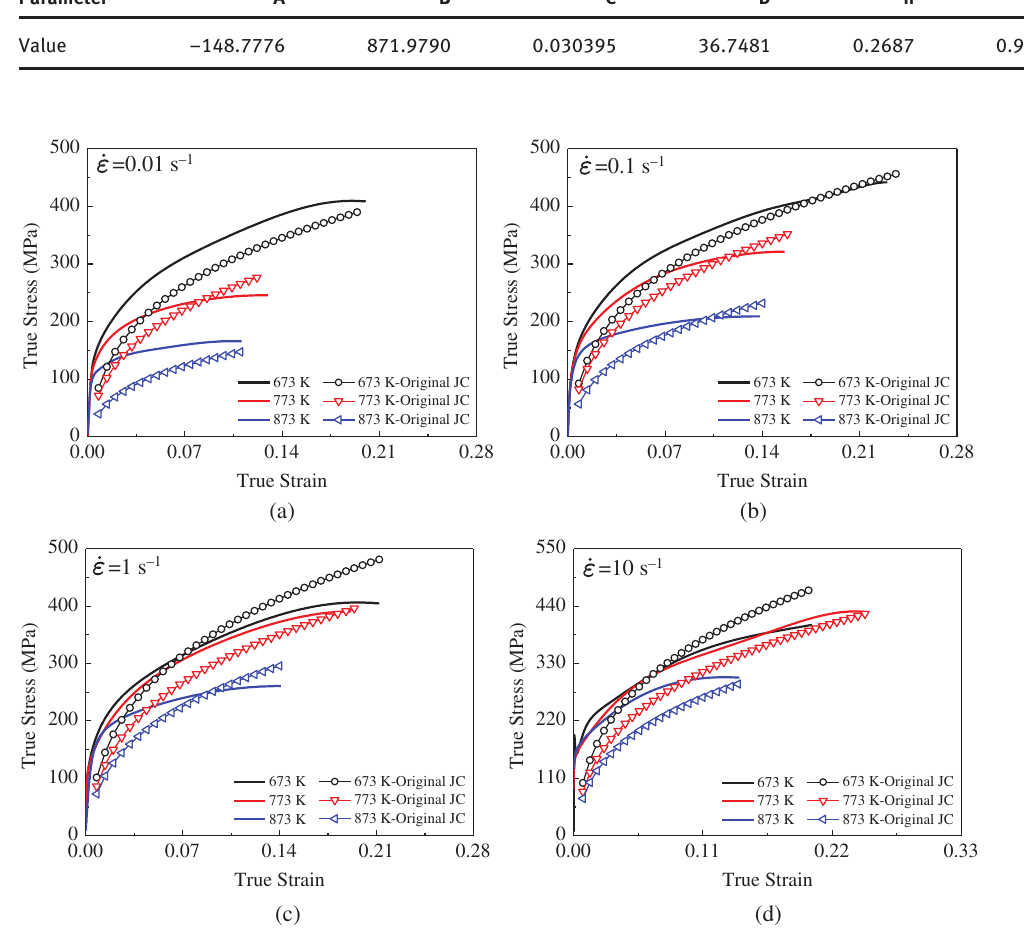
Figure 9: Comparisons between experimental and predicted flow stress by Johnson-Cook model under middle temperature region with the strain rates of (a) 0.01 s − 1 , (b) 0.1 s − 1 , (c) 1 s − 1 and (d) 10 s − 1 .